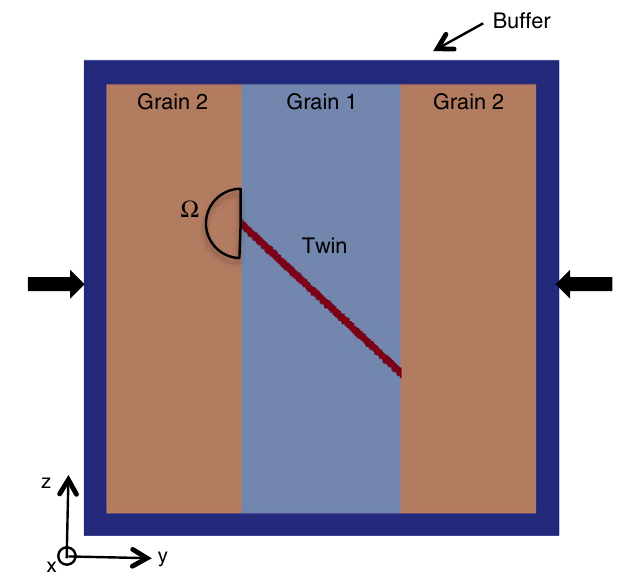
Figure 4 | Fast Fourier transform model set-up. Schematic representation of the tricrystal unit cell. The twin is embedded in a central grain (grain 1) and the twin front is arrested at the grain boundary with the neighbouring grain (grain 2). A buffer layer of random orientations surrounds the tricrystal. This configuration represents a polycrystal in which only three grains are magnified for numerical simulation purposes. The region O in the neighbouring grain is the potential region where twin transmission may occur and where the stresses available for twin transmission are calculated.